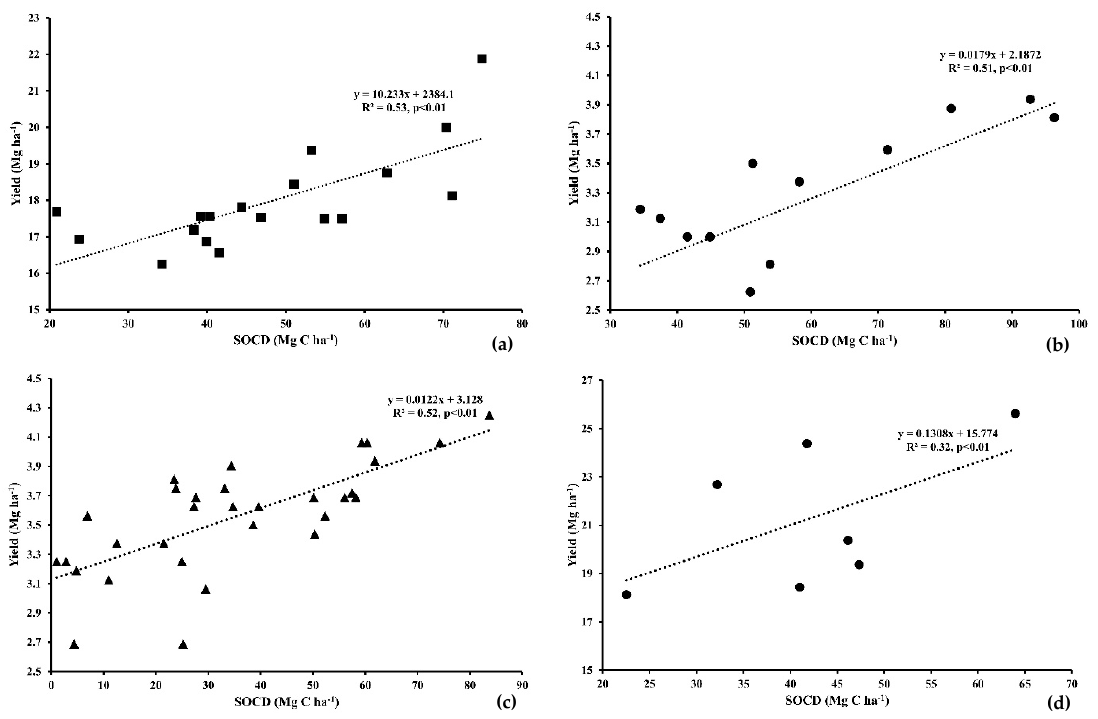
Figure 4. Relationship between SOCD and chemical fertilizers: ( a ) cabbage; ( b ) upland rice; ( c ) lowland rice; ( d ) tomato; ( e ) strawberry; ( f ) potato; ( g ) Japanese pumpkin; ( h ) cape gooseberry; ( i )